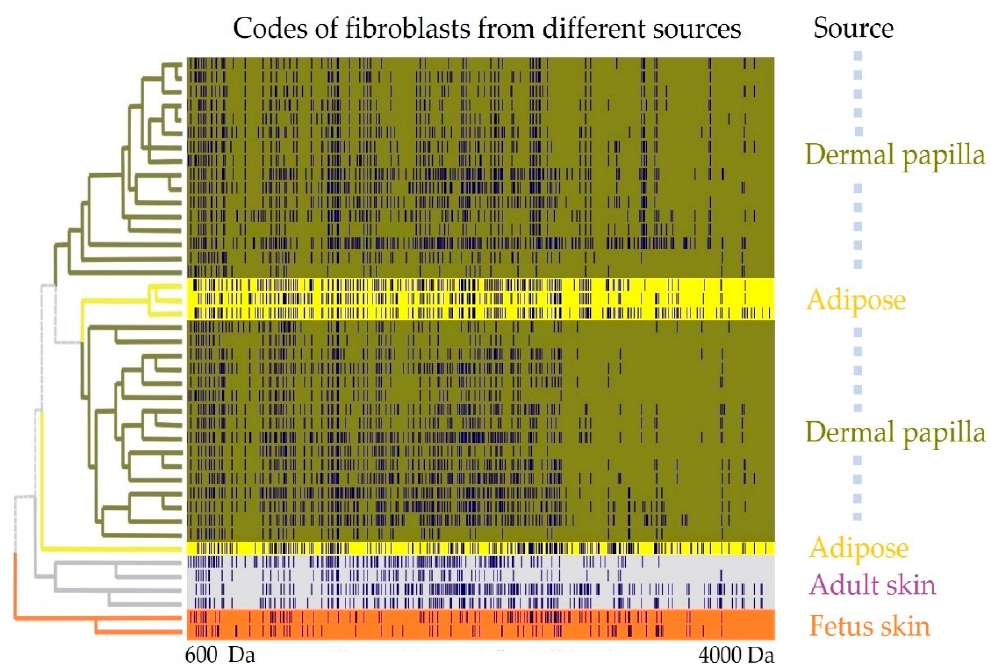
Figure A1. Clustering of SANTAVAC codes obtained for fibroblasts of different origins. Fibroblast cultures were treated with trypsin under noncytolytic conditions. Codes (representing cell proteomic footprints) are represented in log scale and in binary format, where a dash indicates the presence of a measured peptide mass in the corresponding mass spectrum. Codes / footprints were clustered using the Ward method and according to the origin of the fibroblast culture analyzed. Therefore, the SANTAVAC code or cell footprint is specific to cells on the subtype level. Adapted from [50].